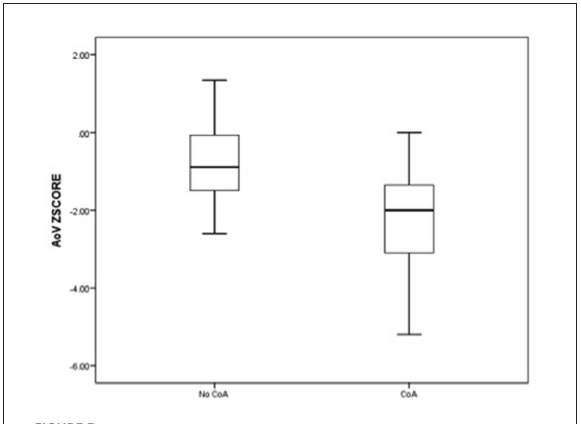
FIGURE3 Box and whisker plots of the z-score, respectively, for aortic valve annulus and the distal transverse aortic arch at the third-trimester echocardiography.